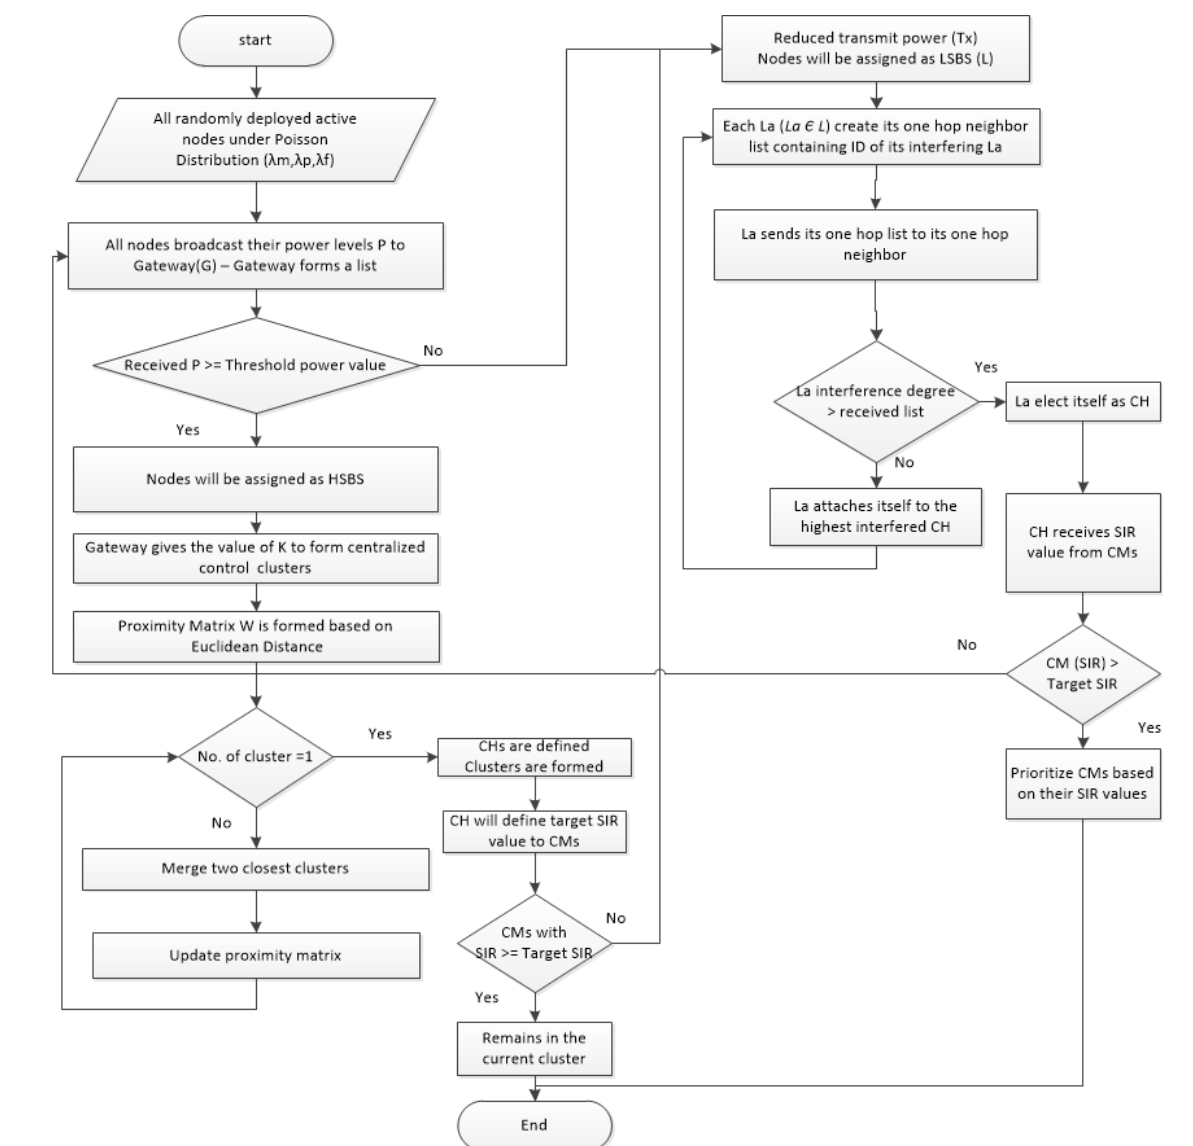
Figure 4. Process flow of the IMHC hybrid clustering scheme.